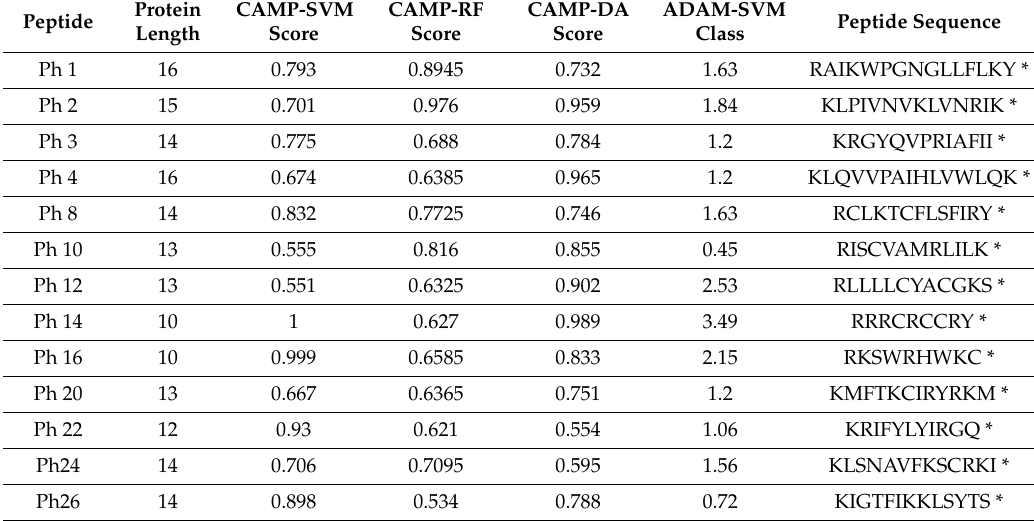
Table 3. Primary sequences of P. hilaris peptides.